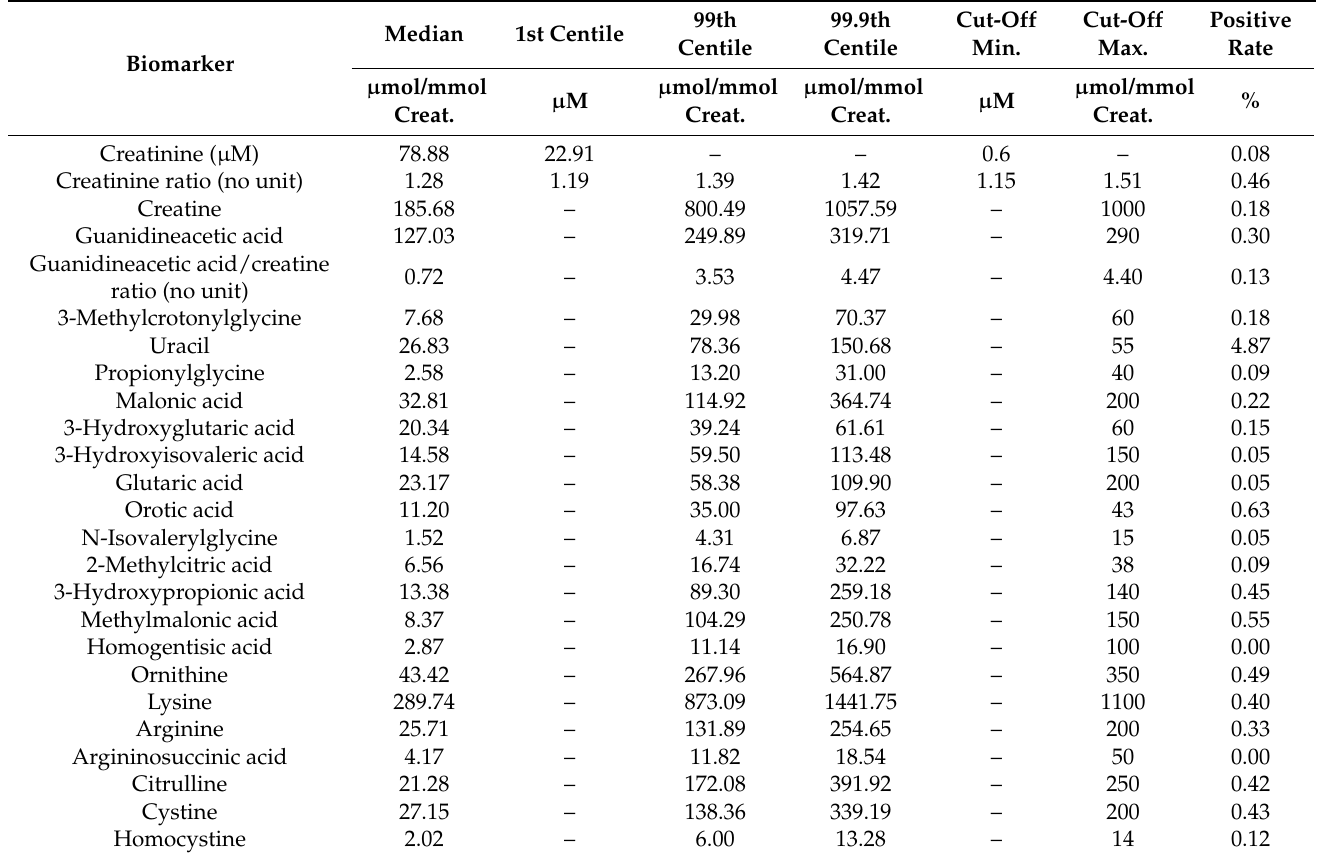
Table 4. Statistical summary of the screening test performed on urine samples from the Newborn Screening Pro- gram ( n = 8227), normal cut-off values for the different biomarkers, and their positive rate. For uracil n = 6697. Creatinine ratio = ratio of the creatinine signal obtained with fragments at m/z 44 and 86. Creat. = creatinine.